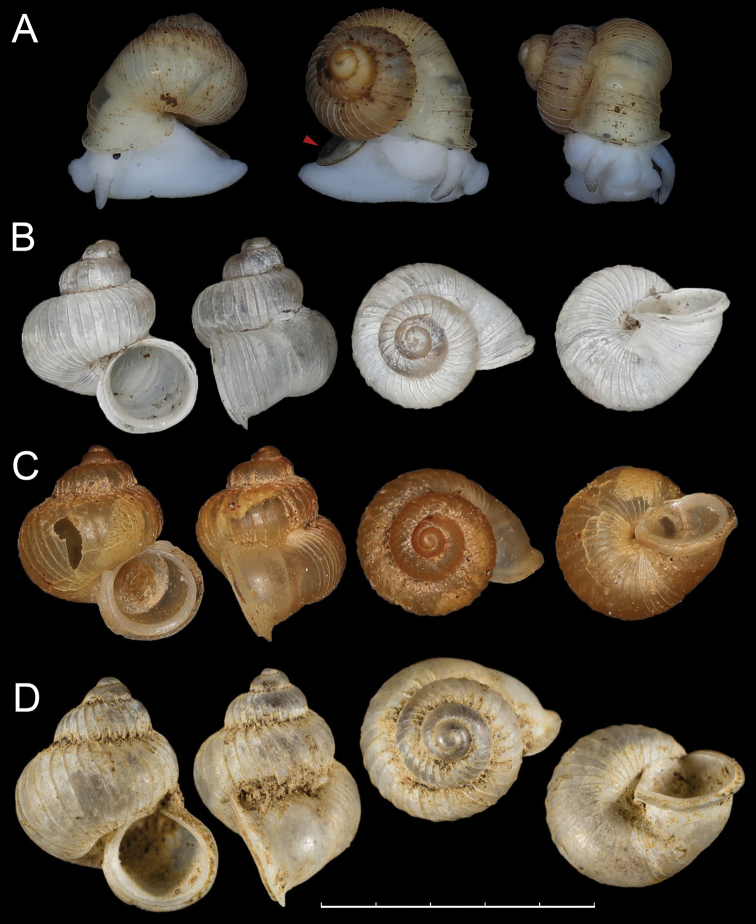
A, BPincerna
vallis Chen & Wu, sp. nov. AHBUMM 10017-spec. 1, holotype, red arrow shows the operculum BHBUMM 10017-spec. 2, paratype C, DPincerna
costulosa (Bavay & Dautzenber﻿g, 1912) C HBUMM10018 D syntype, MNHN-IM-2000-31786. Scale bar: 5 mm. Photos: Zhe-Yu Chen (A–C) and M. Caballer Gutierrez (D).